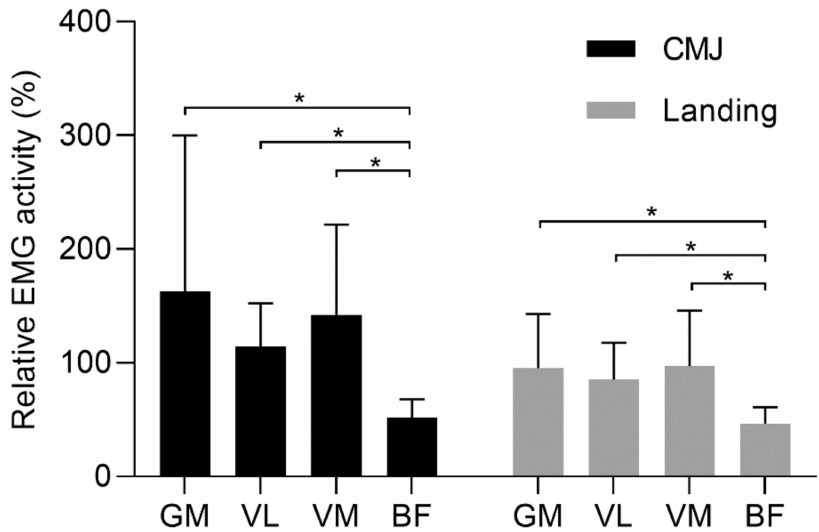
Figure 3. Relative peak EMG activities obtained from gluteus medius (GM), vastus lateralis (VL), vastest medialis (VM), and biceps femoris (BF) muscles during CMJ and landing tasks. * Represents significant difference at p < 0.05.